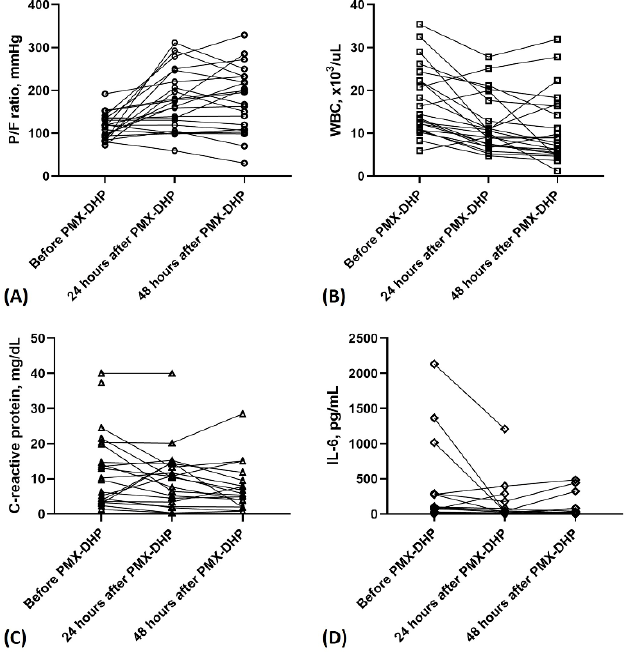
Figure 2. Changes in P/F ratio, white blood cell, c-reactive protein, and interleukin-6 levels before and after polymyxin B-immobilized fiber column (PMX-DHP) treatment. ( A ). P/F ratio, ( B ). White blood cell, ( C ). C-reactive protein, ( D ). Interleukin-6. Table 4. Univariate Cox regression analysis results on 90-day Table 3. Clinical course of laboratory data before and after PMX-DHP treatment based on the Wilcoxon test.